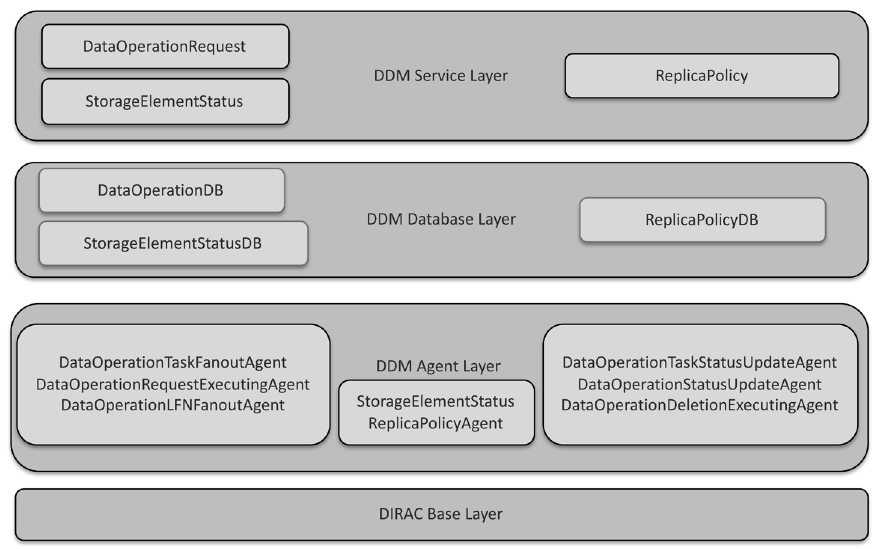
Figure 4: Schematic diagram of the Belle II DDMS components.